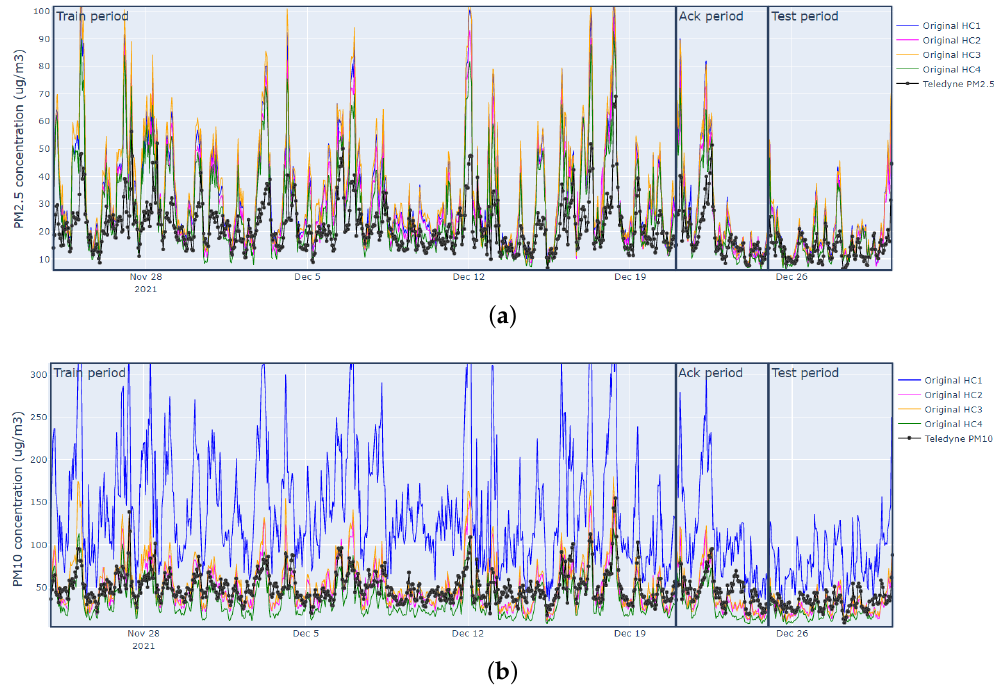
Figure 3. Plots of PM 2.5 and PM 10 hourly data collected by IQAir sensors and reference sensor (Teledyne) during 24 November 2021 to 30 December 2021: ( a ) hourly PM 2.5 series measured by IQAir sensors; ( b ) hourly PM 10 series measured by IQAir